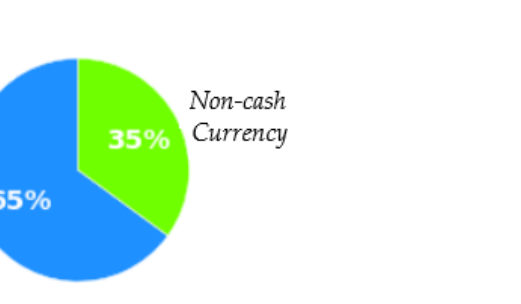
Figure 10. Answers for question of do you think cryptocurrencies are cash or non-cash currency?